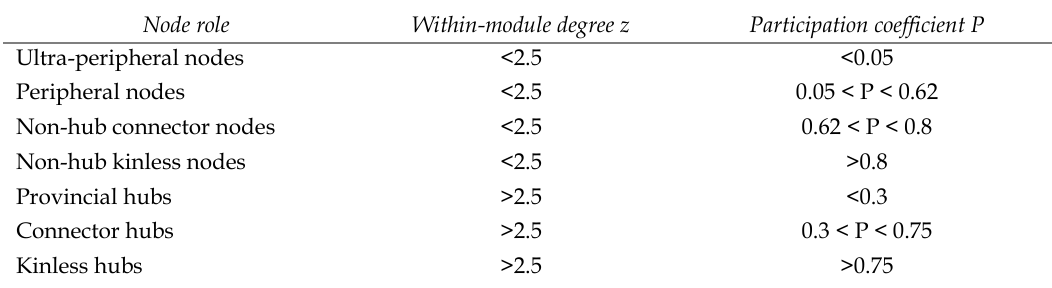
Table 1. Parameters of node connectivity in a network (Guimerà & Amaral,